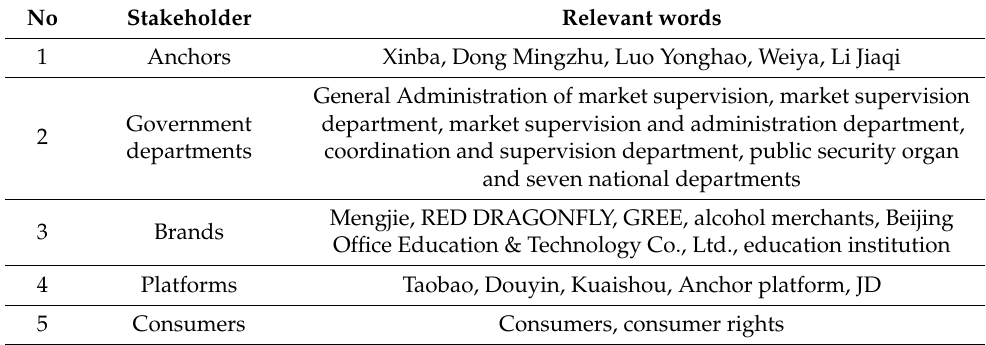
Table 5. Extraction of main subjects in live